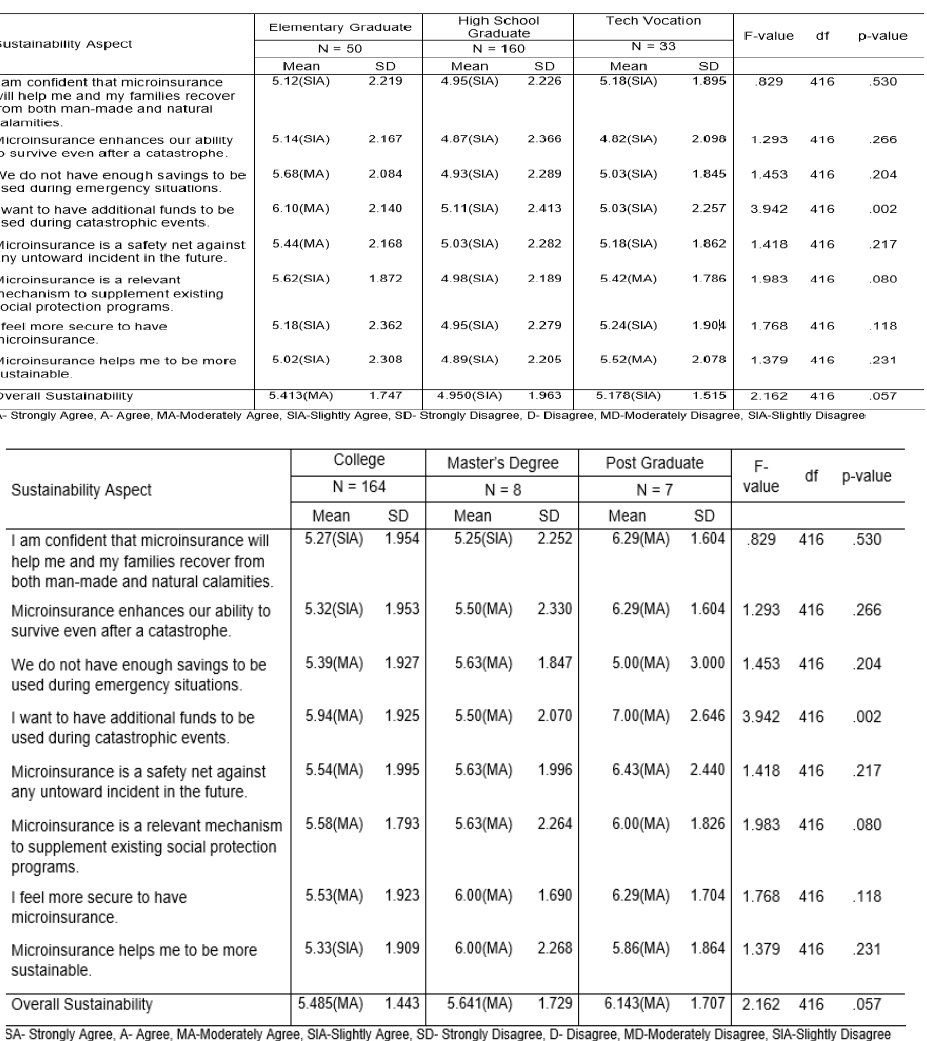
Table 2: Level of Agreement of the Respondents on the Sustainability aspect of Microinsurance When Grouped According